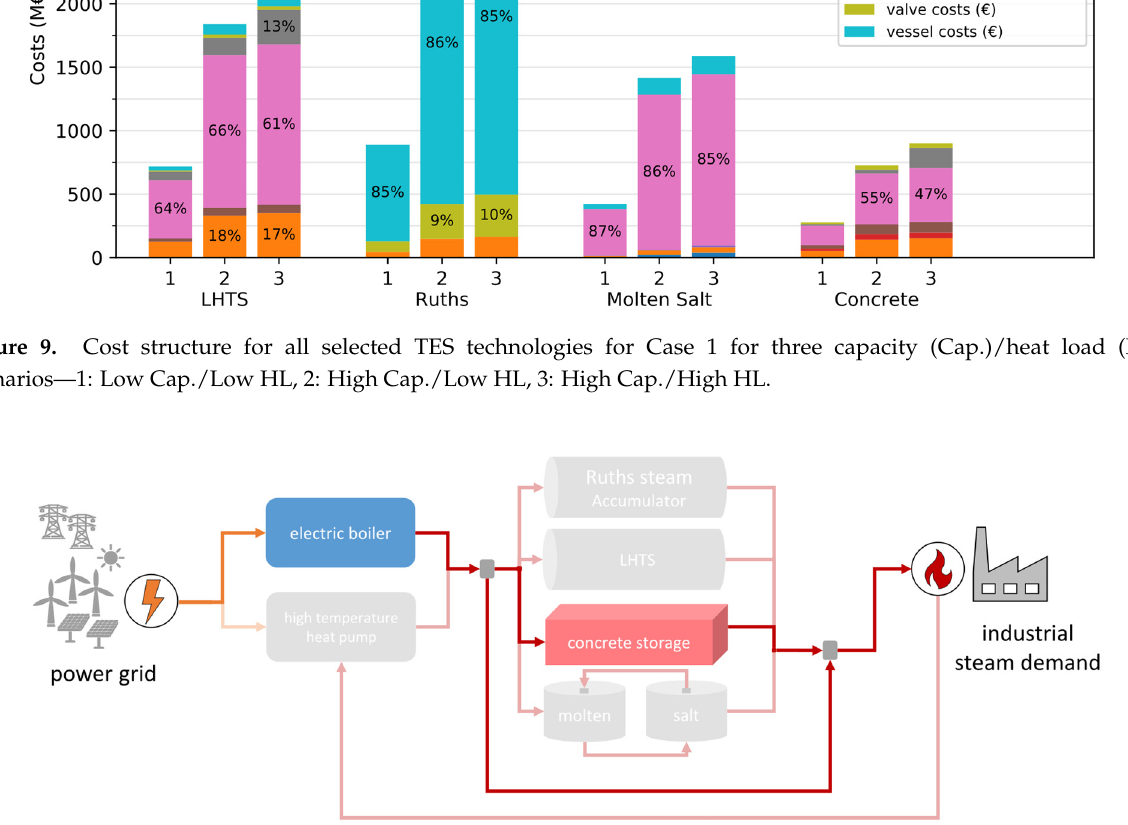
Figure 9. Cost structure for all selected TES technologies for Case 1 for three capacity (Cap.)/heat load (HL) scenarios—1: Low Cap./Low HL, 2: High Cap./Low HL, 3: High Cap./High HL.